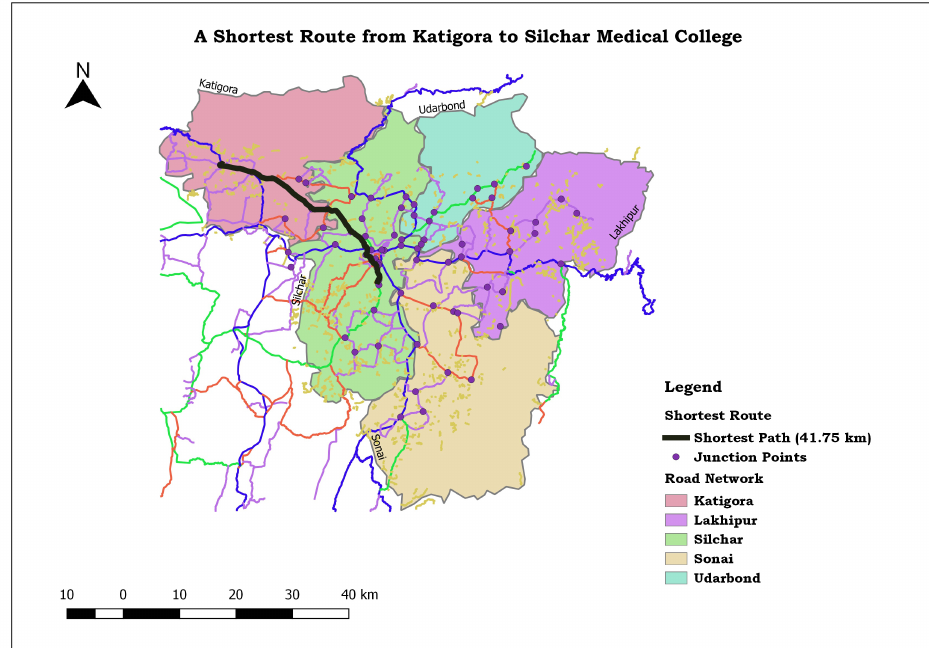
Figure 9. A shortest route from Katigora to Silchar Medical College. Similarly, there are several available roads to reach Assam University from Lakhipur town. QGIS determines that the shortest one is of length 51.36 km and is displayed in red in Figure 10.